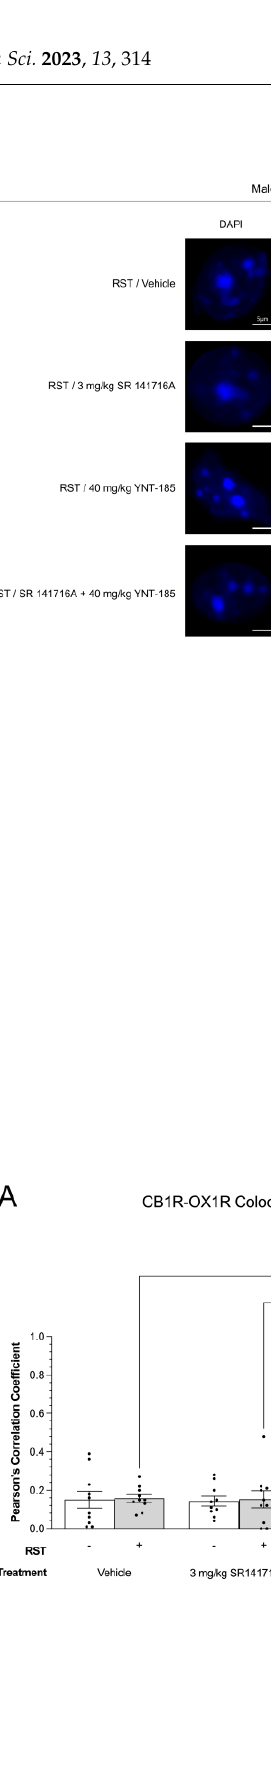
Figure 7. Colocalization of CB1R and OX1R in female mesocorticolimbic brain regions as a result of prolonged restraint stress and drug treatments. ( A – C ), CB1R-OX1R colocalization in the VTA ( A , D ), NAC ( B , E ), and MPFC ( C , F ) of 200 µL vehicle, 3 mg/kg SR141716A, 40 mg/kg YNT-185, and 3 mg/kg